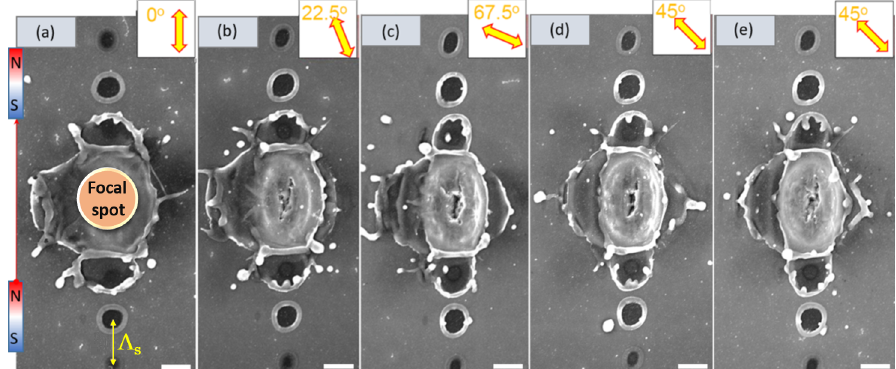
Figure 3. SEM images of the ablation sites under high intensity single pulse exposure on Si, with an externally applied magnetic field: (all scale bars = 1 µ m) all parameters and geometry were constant except incident light polarisation. The angular polarisation (E-field) dependence is shown in insets. ( a ) 0 ◦ linear polarisation of incident light (parallel to B field direction) ( b ) 22.5 ◦ incident light polarisation ( c ) 67.5 ◦ incident light polarisation ( d ) 45 ◦ incident light polarisation ( e ) 45 ◦ incident light polarisation repeated. The gap between magnets x = 2.5 mm and magnetic field B = 0.156 T. The period Λ s of SPP pattern was constant. Pulse energy and focusing conditions were like those seen in Figure 1. For the tilted-SEM view, see Figure A1.